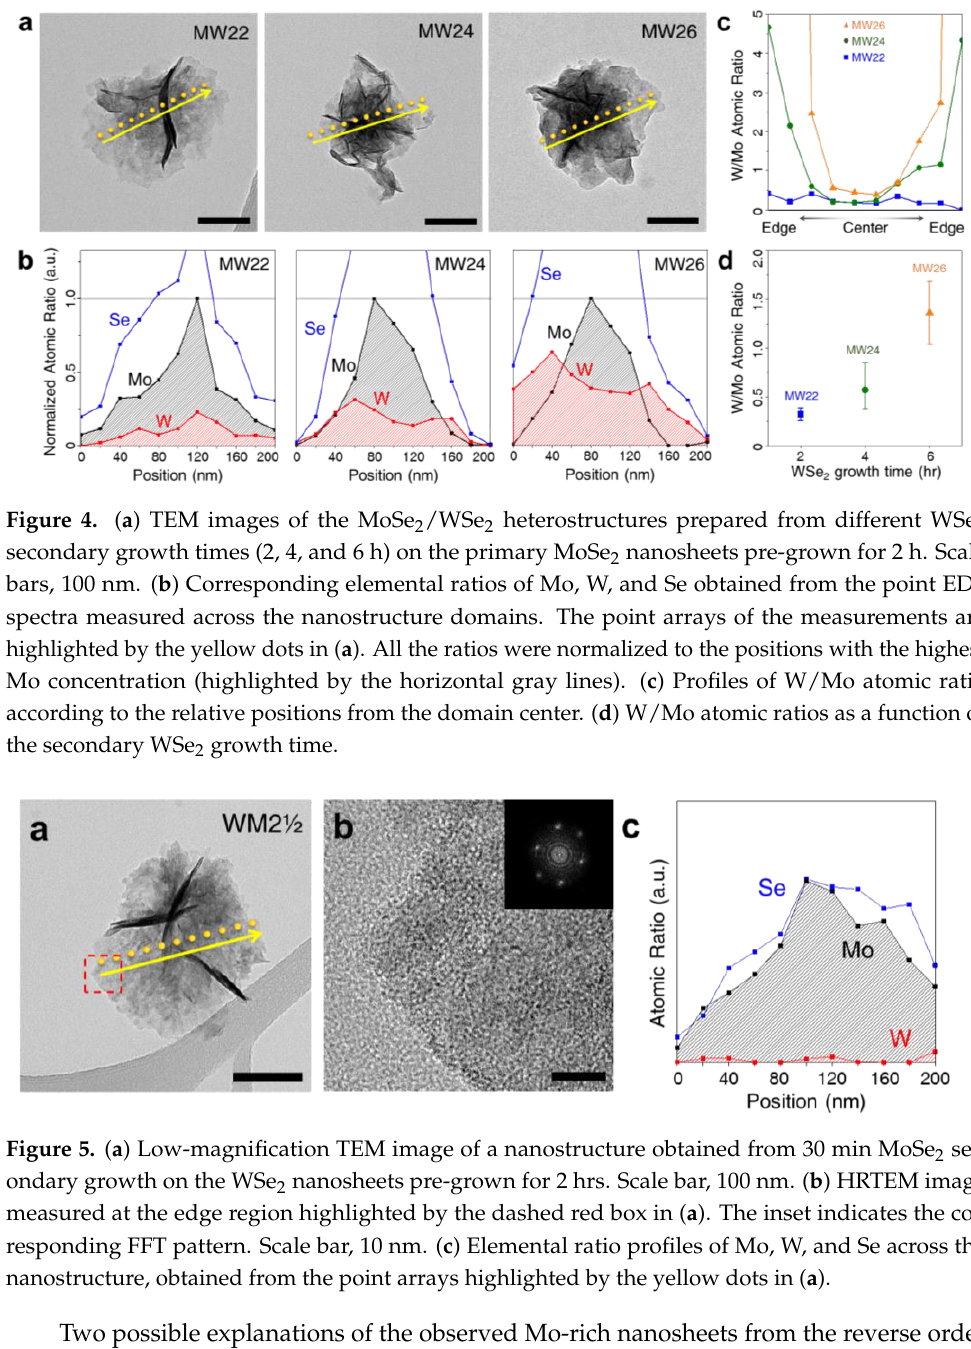
Figure 5. ( a ) Low-magnification TEM image of a nanostructure obtained from 30 min MoSe 2 sec- ondary growth on the WSe 2 nanosheets pre-grown for 2 hrs. Scale bar, 100 nm. ( b ) HRTEM image measured at the edge region highlighted by the dashed red box in ( a ). The inset indicates the corre- sponding FFT pattern. Scale bar, 10 nm. ( c ) Elemental ratio profiles of Mo, W, and Se across the nanostructure, obtained from the point arrays highlighted by the yellow dots in ( a ).